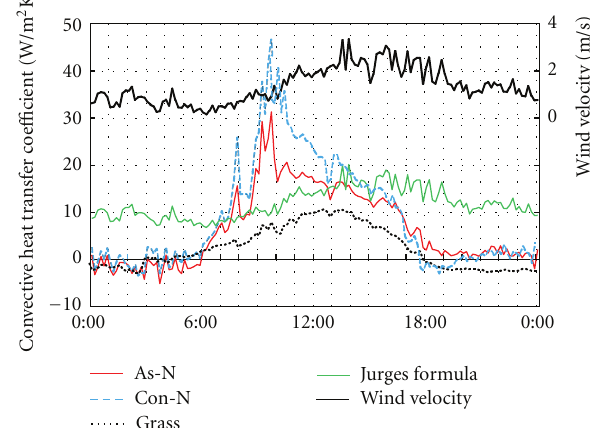
Figure 11: Estimated values of sensible heat transfer coe ffi cient on August 4,